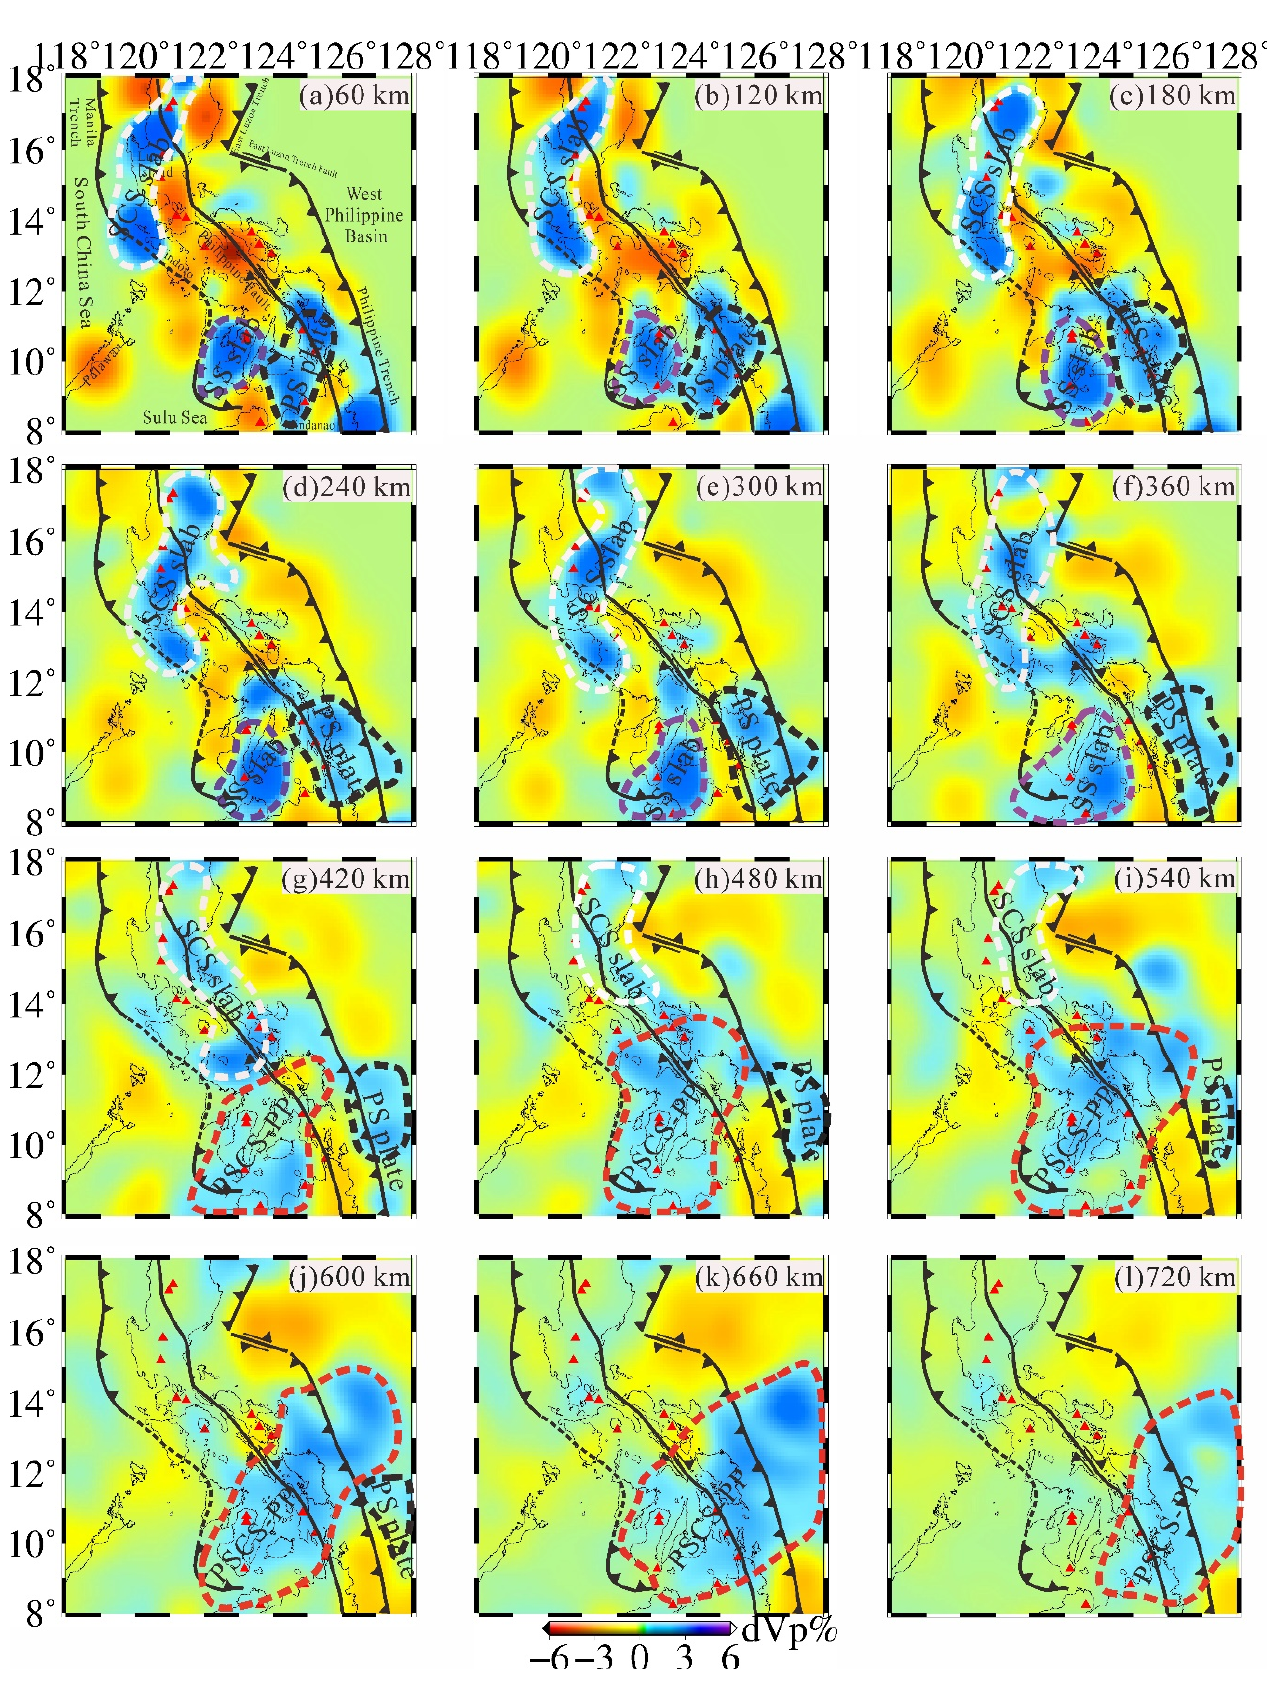
Figure 7. Map view of the tomographic model in the different depth. Fast anomalies are denoted by blue color, slow anomalies are denoted by red color. The color bar of the anomaly is located at the bottom. Red triangles indicate volcanoes.